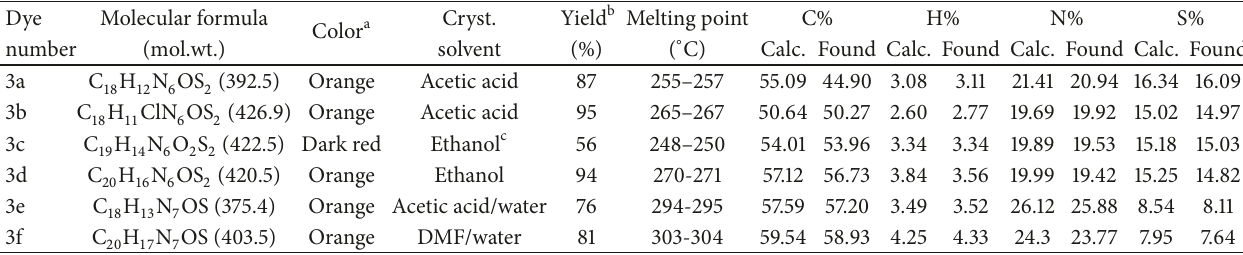
Figure 1: The general route for the synthesis of dyes 3a–3f. Table 1: Characterization data and elemental analysis of dyes